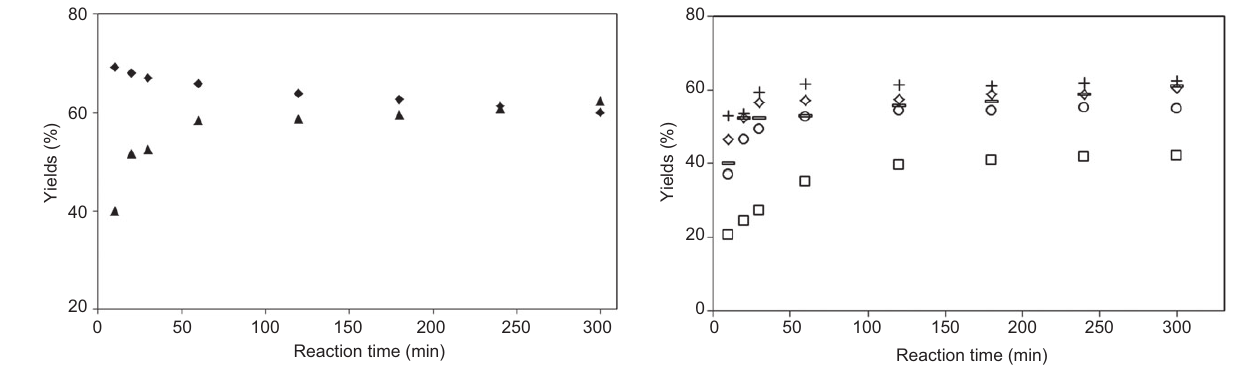
catalyst loading vs. time 2